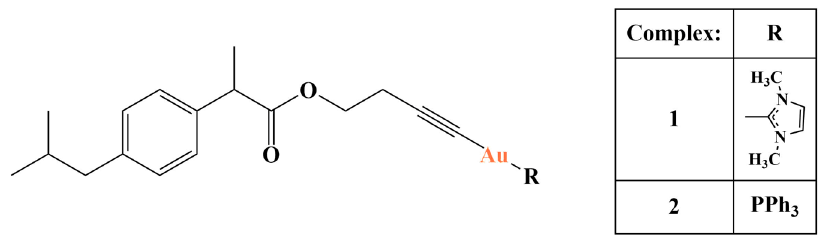
Figure 34. One of the complexes presented in [119].